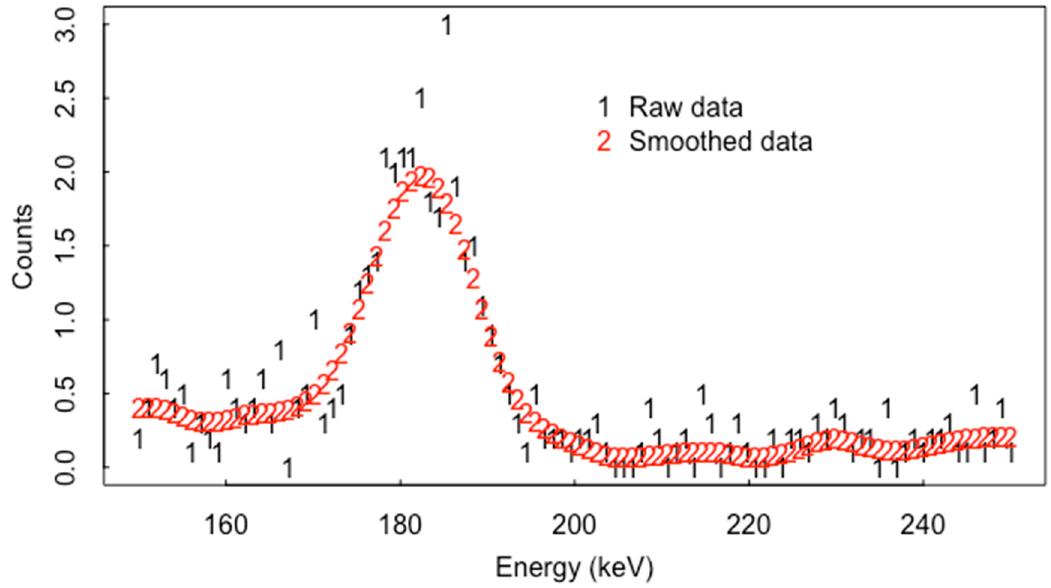
Figure 7. Example of simulated raw and smooth spectra with a single true peak at 183.3 keV. Algorithms 2020 , 13 , x FOR PEER REVIEW